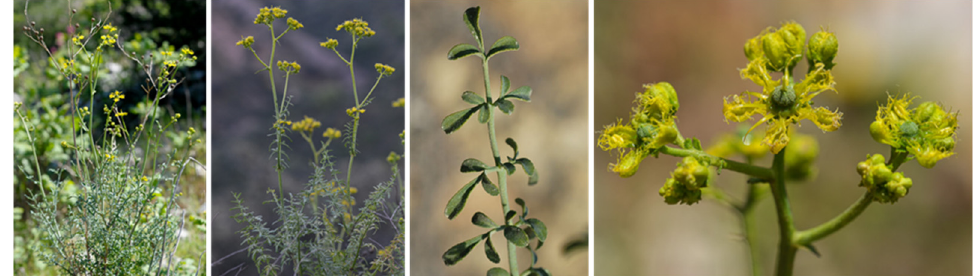
Figure 1. The plant Ruta angustifolia Pers. (FloresAlpes, https://www.florealpes.com) accessed on 17 December 2022.